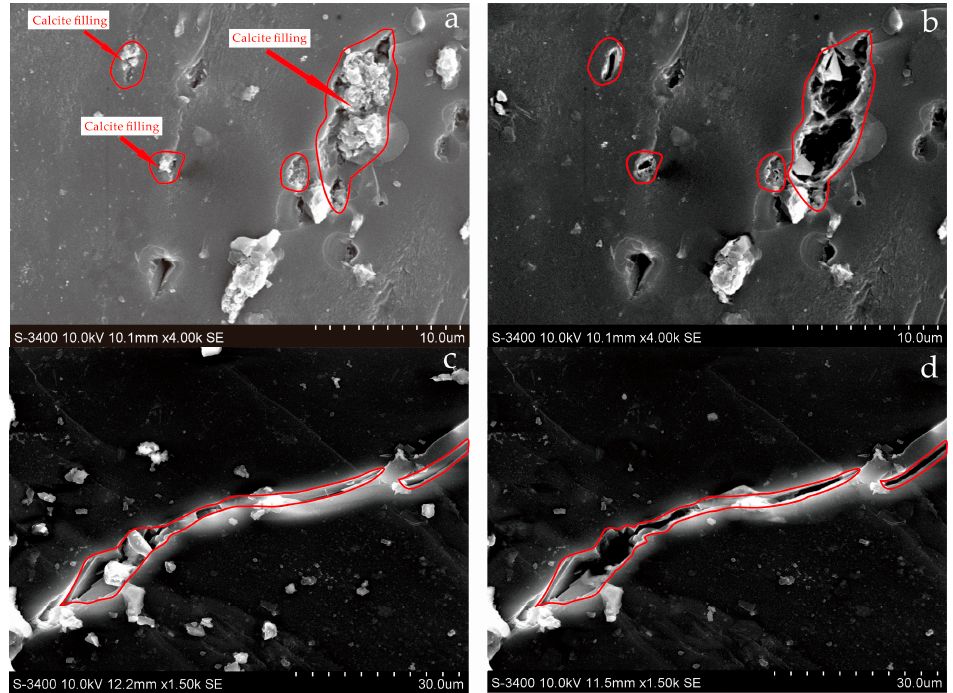
Figure 5. SEM images of untreated ( a , c ) and treated ( b , d ) coal samples. ( a , b ) present nano-scale pores on the surface of coal matrix before and after treatment; ( c , d ) present natural fractures before and after treatment.